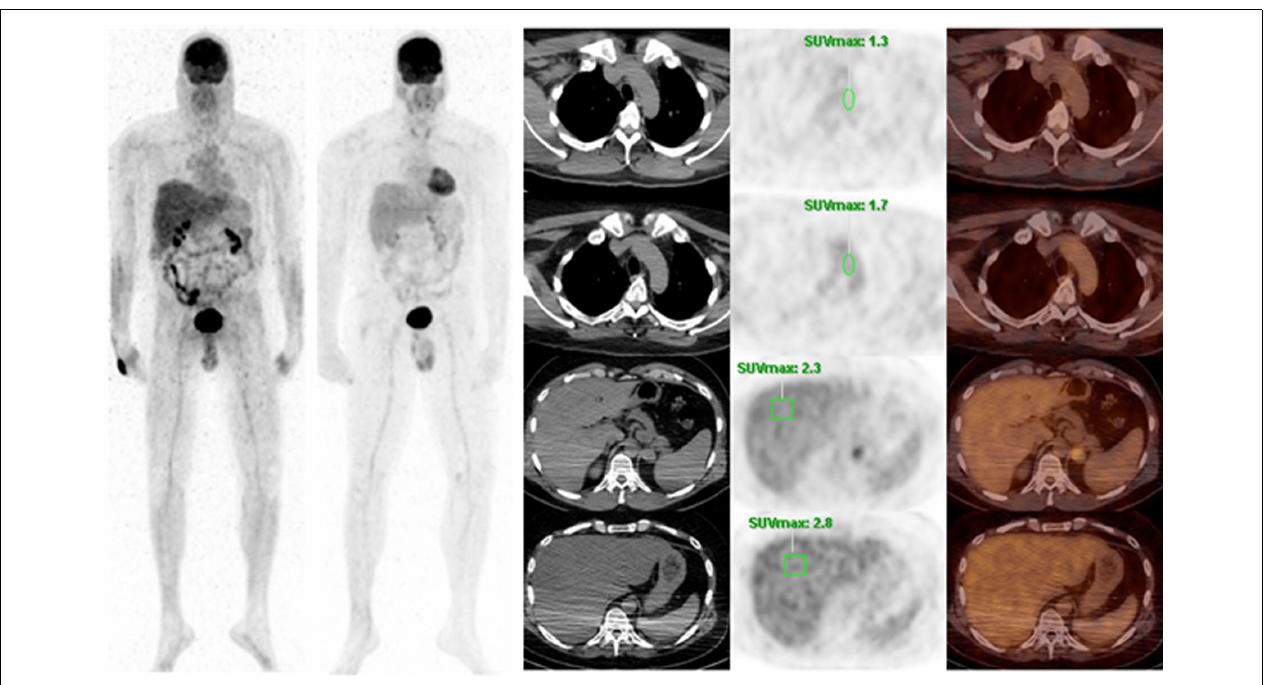
FIGURE 3 | Patient is a 46-year-old male with a history of melanoma. Left MIP shows extravasation in the right wrist and a repeat PET was performed 5months later with no extravasation.The top row shows SUV measurement of the mediastinum with extravasation and the second row shows SUV of the mediastinum without extravasation.The third row shows SUV of the liver with extravasation and the bottom row shows SUV of the liver without